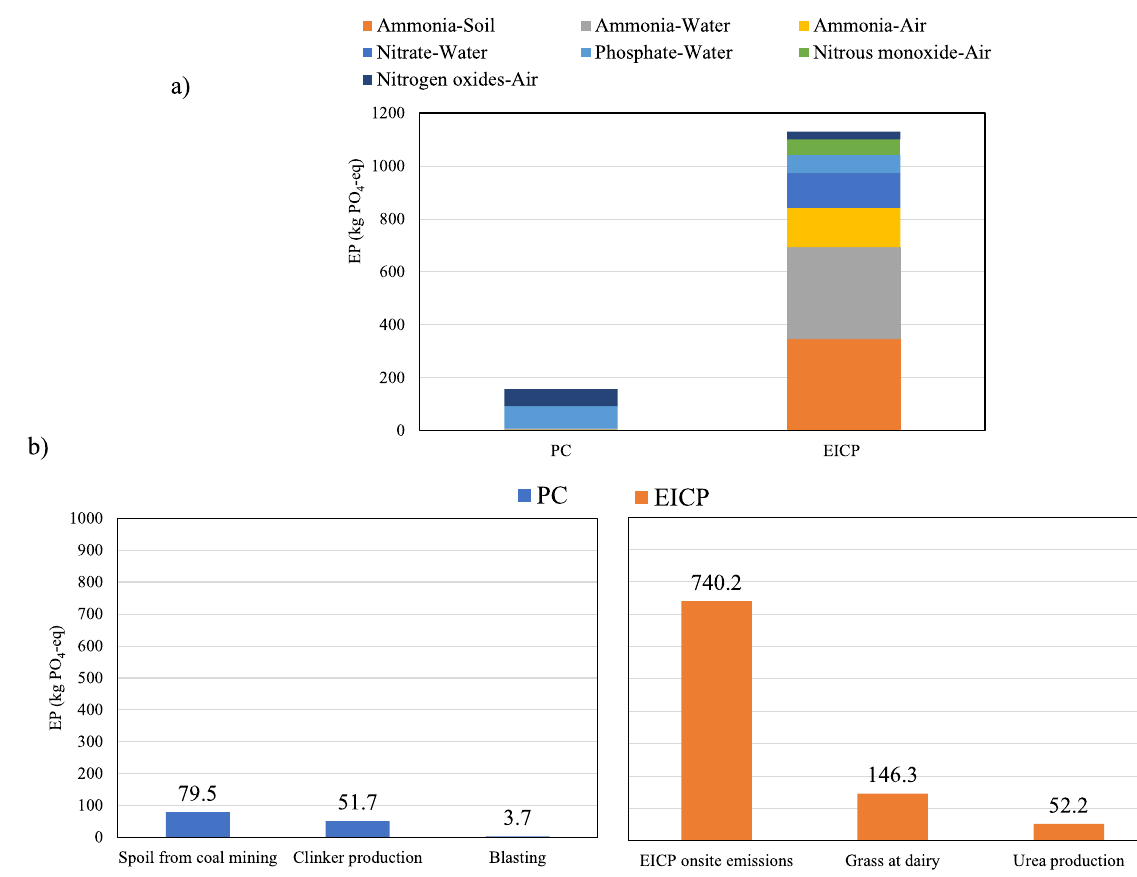
Figure 4. Eutrophication potential of the PC and EICP soil stabilization techniques: ( a ) total and individual emissions, and ( b ) highest contributing